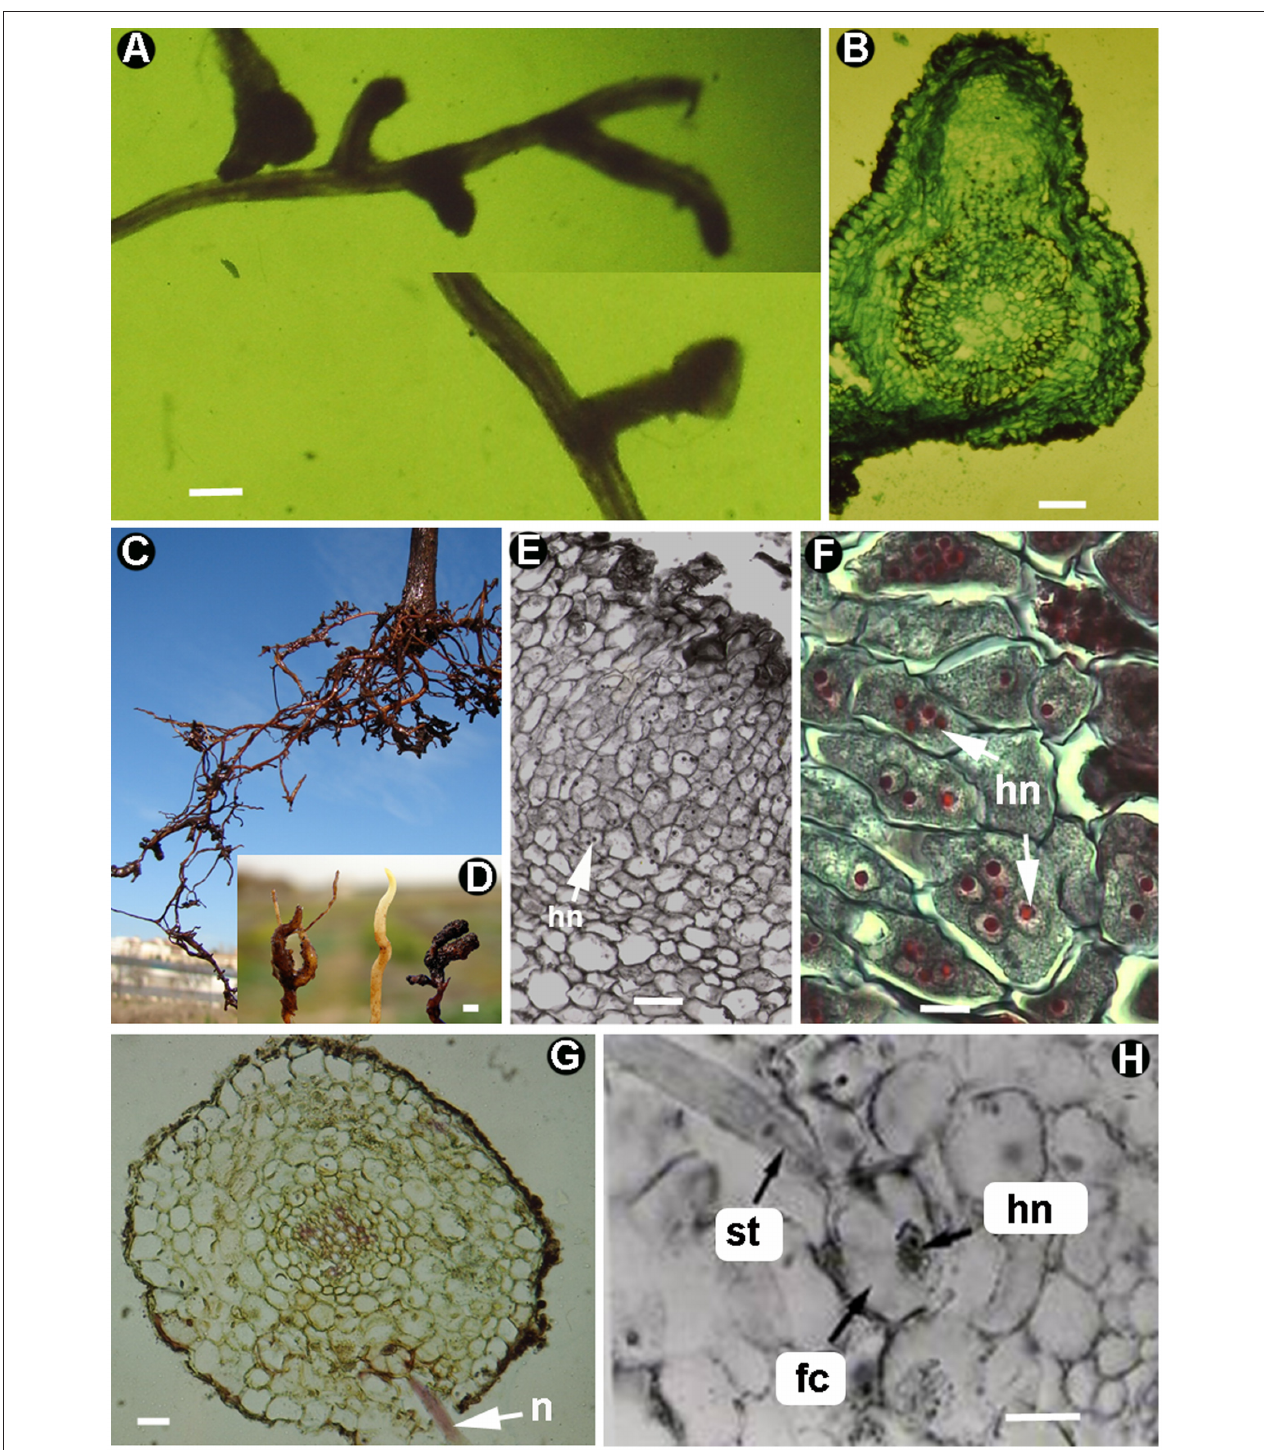
FIGURE 2 | Morphogenesis caused by ectoparasite root nematodes. Paratrichodorus teres (A,B) : (A) Apical-root galls on wheat. (B) Cross-section of apical-root wheat gall (Source: N. Vovlas). Xiphinema index (C–F): (C, D) Apical-root galls in grapevine. (E,F) Cross-sections showing multinucleate cells with hypertrophied nucleus (hn) induced by nematode parasitism (Gutiérrez-Gutiérrez et al., 2011; with permission of John Wiley and Sons). Helicotylenchus oleae (G,H) : Cross-sections of olive roots showing the nematode feeding on a parenchymatic feeding cell (fc) with hypertrophied nucleus (hn) (Source: N. Vovlas). fc, feeding cell; hn, hypertrophied nucleus; n, nematode; st, stylet. Scale bars: A,D = 1,000 µ m; B = 200 µ m; E = 10 µ m; F,H = 20 µ m; G = 100 µ m.